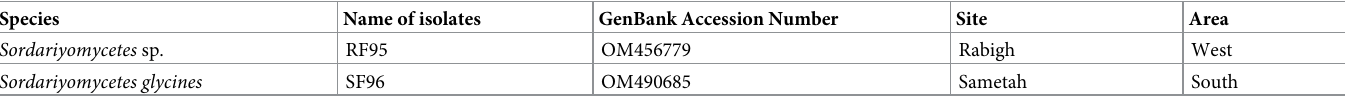
The highest negative PC2 scores (inhibitors of bacteria) were for the genera Phompsis > Buellia > Aspergillus > Microdochium > Ceratocystis . The species identified were P . glabrae . B . lauricassiae , M . anisopliae , and C . polychorma . P . glabrae and one Aspergillus sp. were iso- lated from the Red Sea, while the rest of the most efficient mentioned were isolated from the Arabian Gulf. The isolates of the genera Emericellopsis and Microdochium were either on the negative or positive sites of the PC2-axis.